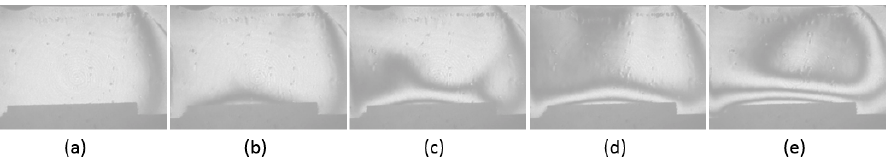
Figure 4. Sequence of formation of the interference fringes during heating. ( a ) Sample at the beginning of heating. ( b ) Formation of the first fringe, 6 min. ( c ) Beginning of the formation of the second fringe, 13 min. ( d ) Fully formed second fringe, 15 min. ( e ) Three visible fringes, 22 min. The interference patterns were projected onto a screen and were recorded by a camera at 15 s intervals. A two sample per minute interval was chosen from the obtained images. The temperature profile of the thermal boundary layer above the sample was obtained by the analysis of interferograms using the Vibra program. The program used the implemented Equations (1) for the calculation of the temperature and (3) for the calculation of the heat transfer coefficient. Each interferogram was analyzed at five sections. The resulting coefficient for each interferogram was calculated as a mean of five acquired values.